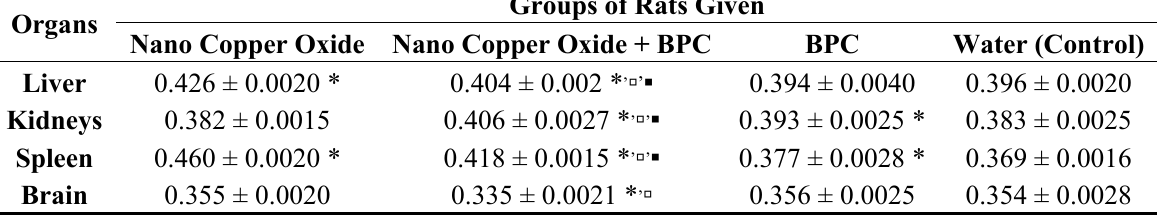
Table 3. Coefficients of the genomic DNA fragmentation in rats after repeat intraperitoneal injections of copper oxide nano-suspensions and/or oral administration of the bioprotective complex (BPC) based on the results of Random Amplification of Polymorphic DNA (RAPD)-test, ( х ± S х